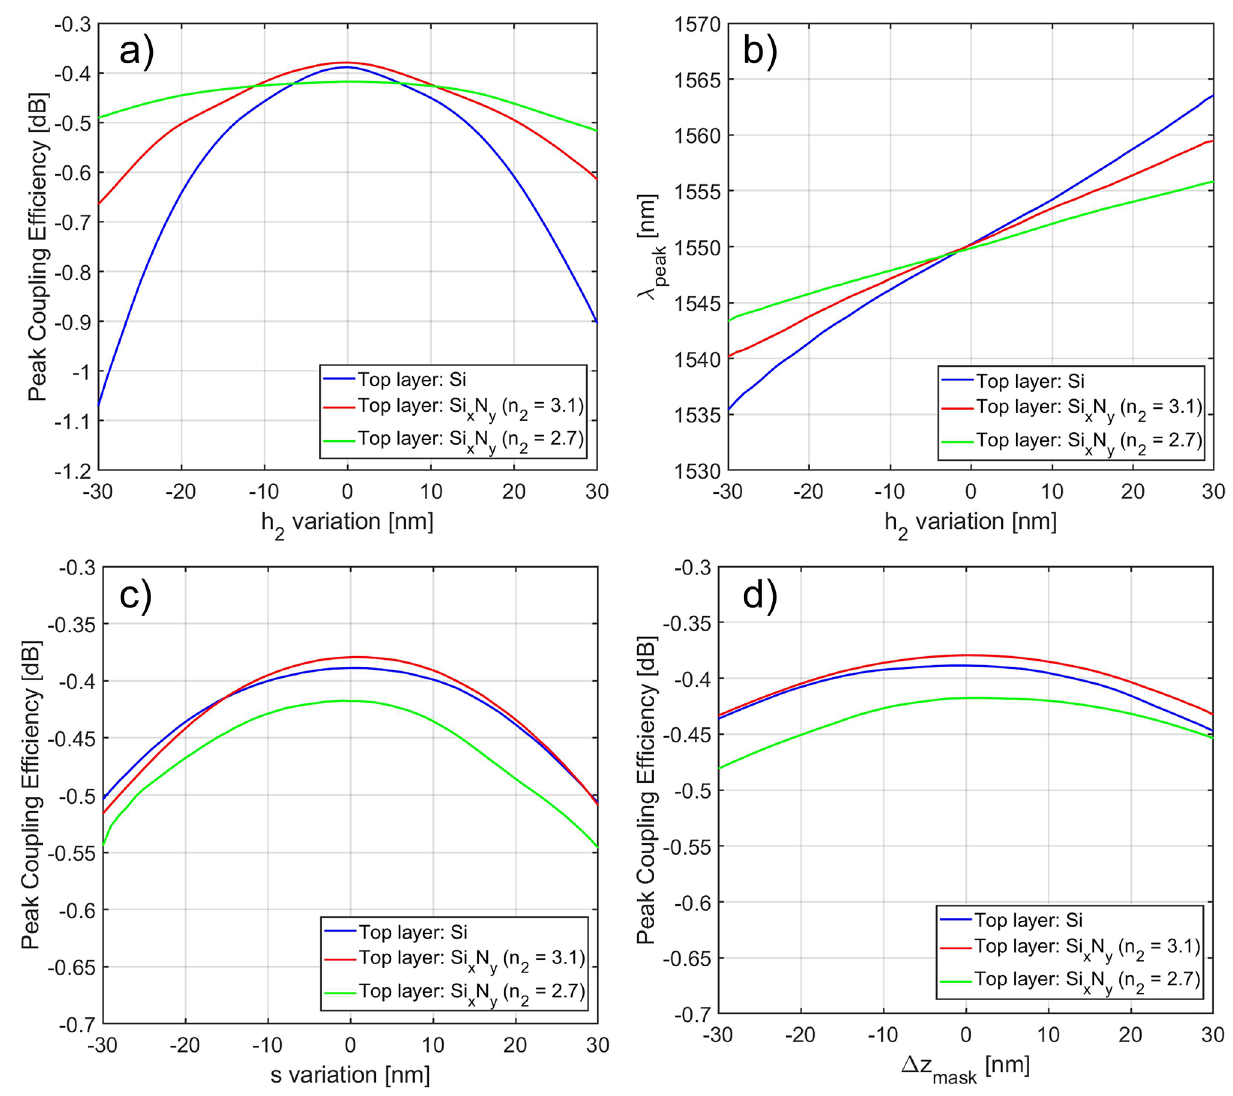
Figure 8. Grating sensitivity to critical fabrication parameters: peak CE dependence on ( a ) top thickness h 2 , ( c ) distance between the two layers s and ( d ) layers misalignment (cid:31) z mask variation; ( b ) peak wavelength dependence on h 2